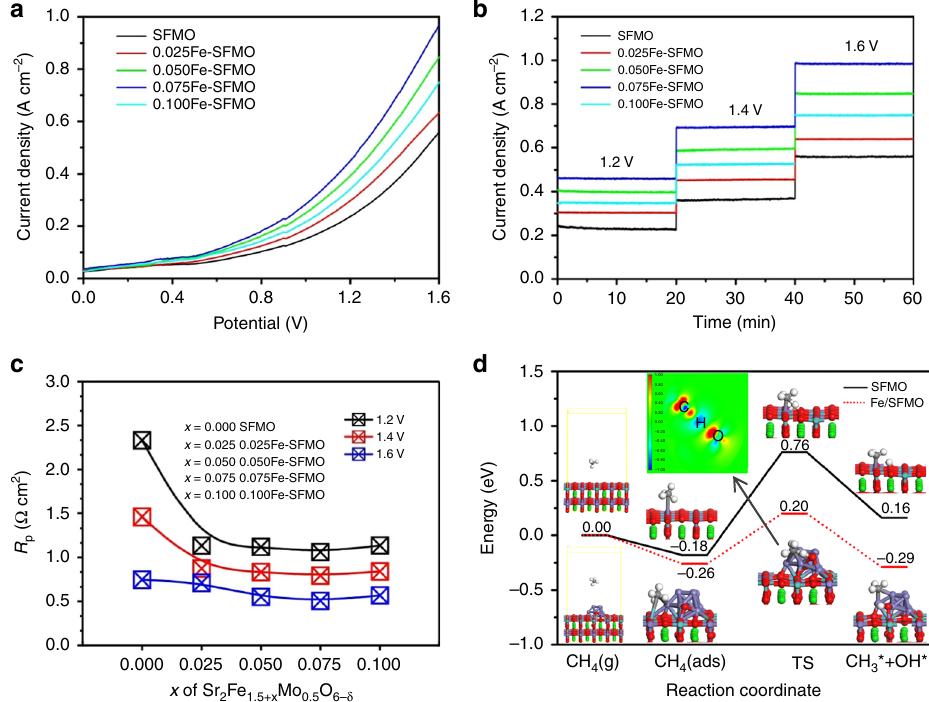
Fig. 3 Electrochemical oxidation of CH 4 at the anode in conjunction with O 2 electrolysis. a The current density – voltage ( I – V ) curves of the electrolyzers with different cathodes for CH 4 oxidation at 850 °C. b The short-term operation of CH 4 oxidation with the composite anodes at different voltages. c The electrode polarizations with different cathodes at 1.2 – 1.6 V at 850 °C. d Energy diagrams for adsorption and C – H bond cleavage of CH 4 on SFMO (001) and Fe/SFMO (001) including their initial, transition, and fi nal states. Inset: electronic charge density difference for the transition state of Fe/SFMO